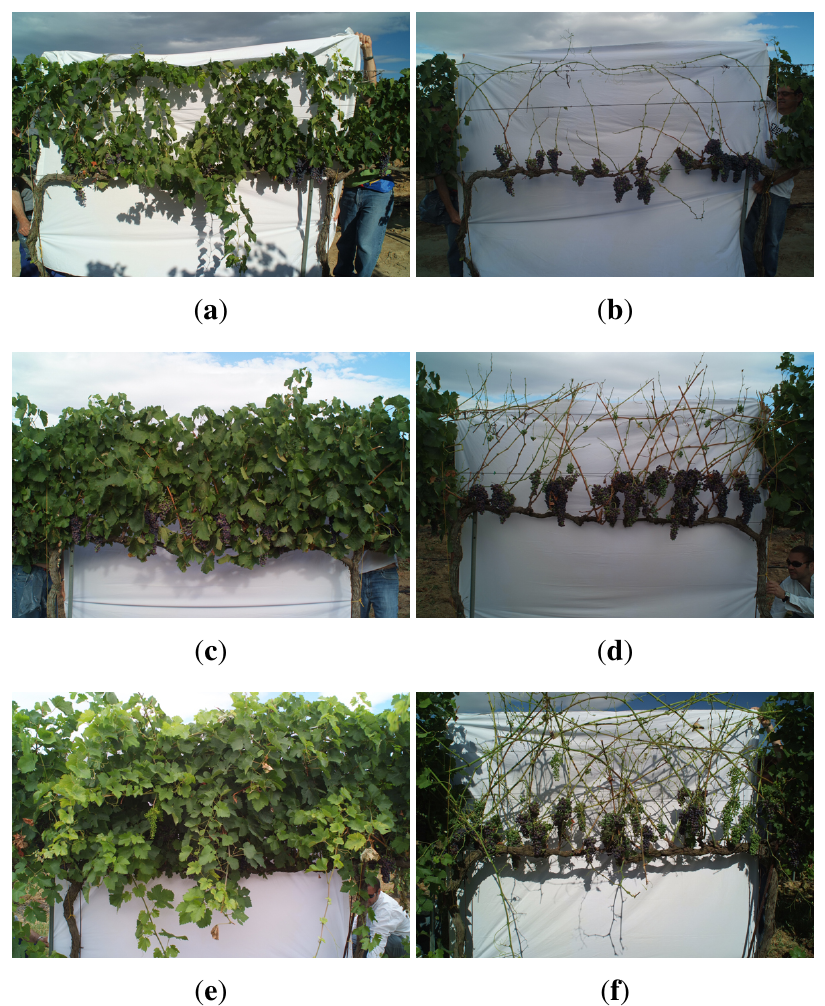
Figure 20. Vineyard row sections with different levels of vigor. ( a ) Row section of low vigor; ( b ) row section of low vigor after defoliation; ( c ) row section of medium vigor; ( d ) row section of medium vigor after defoliation; ( e ) row section of high vigor; ( f ) row section of high vigor after